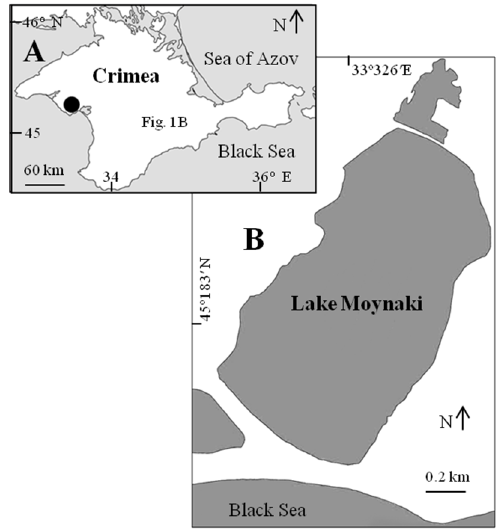
Figure 1. Map of the hypersaline Lake Moynaki ( A ) —the Crimean scale, ( B ) —the local scale).